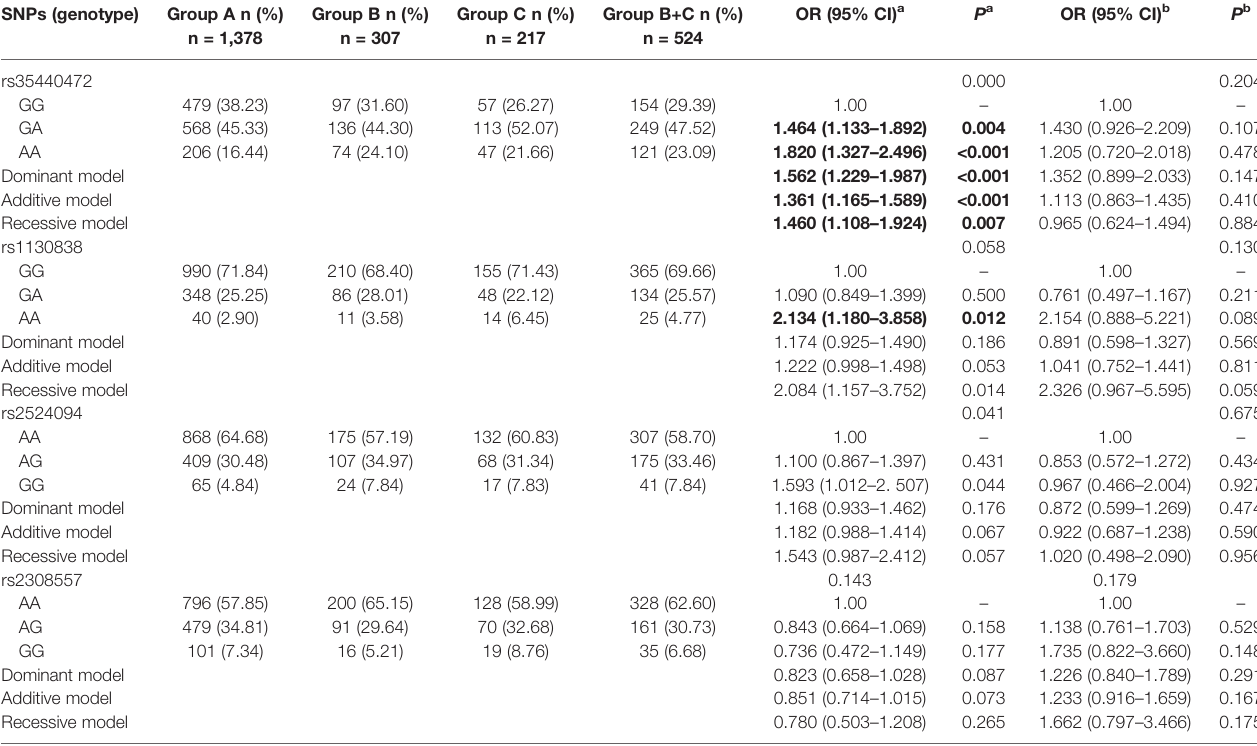
TABLE 2 | Genotypes distributions of KIR/HLA-C genes among HCV control, spontaneous clearance, and persistent infection groups. SNPs